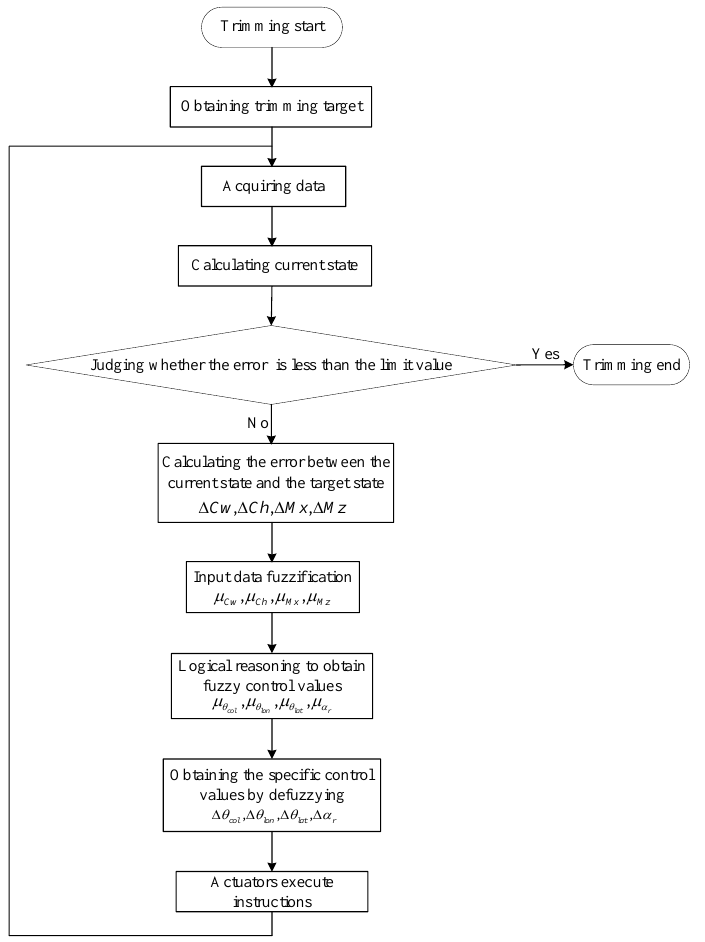
Figure 4. The fuzzy-control automatic trimming